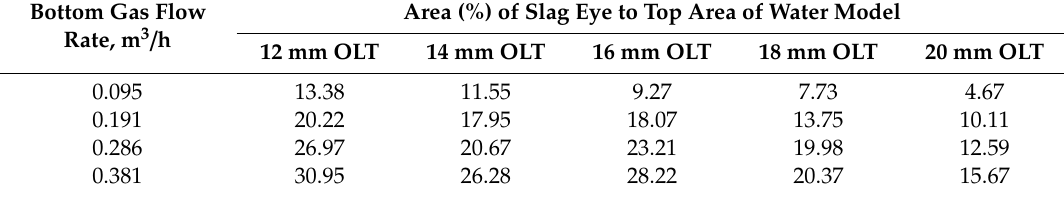
Table 5. The areas of the slag eye at a different bottom flow rate and top oil thickness in the water model with a double porous plug.